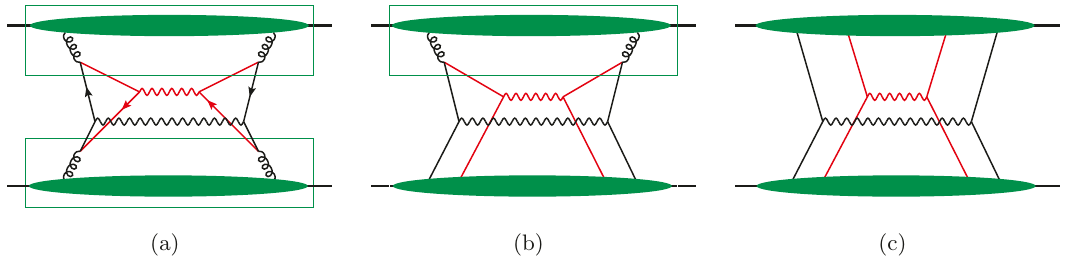
Figure 1 . (a) A 1v1 contribution to DPS, with perturbative splitting DPDs for each proton (indicated by the boxes). (b) A 2v1 contribution to DPS, with a perturbative splitting DPD in only one proton (indicated by the box). (c) A 2v2 contribution to DPS. Here and in the following it is understood that partons emerging from the oval blobs are approximately collinear to their parent proton. A line for the final state cut across the blobs and the produced vector bosons (wavy lines) is not shown for